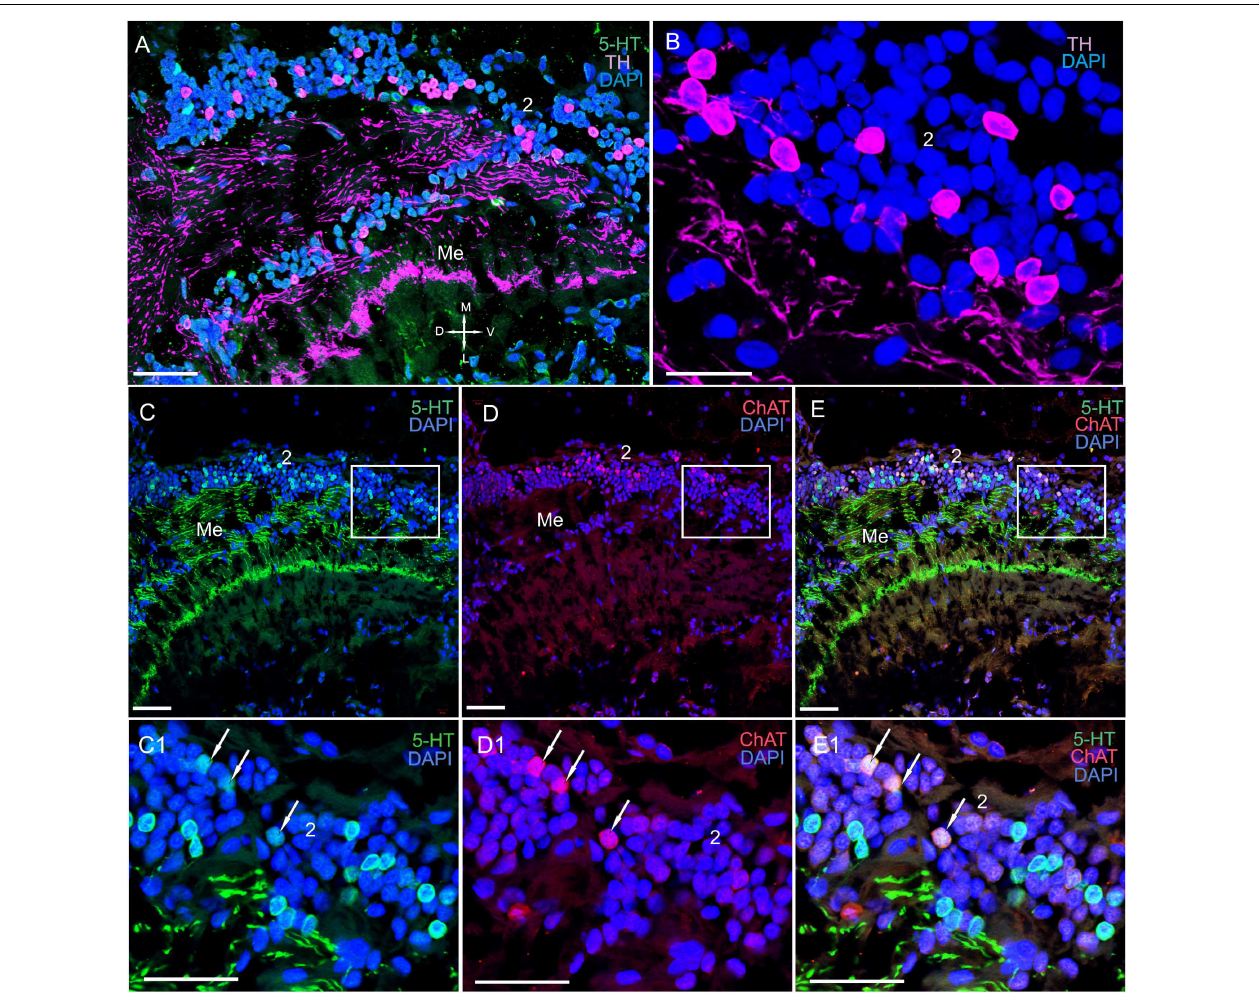
FIGURE 5 | Immunolocalization of 5-HT, TH, and ChAT in the medulla. (A) TH- and 5-HT-positive neurons and nerve fibers in the Me. (B) Immunohistochemical localization of TH in neurons of cell cluster 2. (C–E) Double immunolabeling of 5-HT and ChAT in neurons and nerve fibers of the Me. (C1–E1) Higher magnification of 5-HT- and ChAT-positive neurons of the Me. Arrows indicate colocalization of 5-HT with ChAT in some of the neurons. Green, 5-HT; red, ChAT; magenta, TH; blue, DAPI. Scale bars = (A,C–E1) 100 µ m and (B) 50 µ m. Me, medulla; 2, cell clusters; D, dorsal; V, ventral; L, lateral; M,